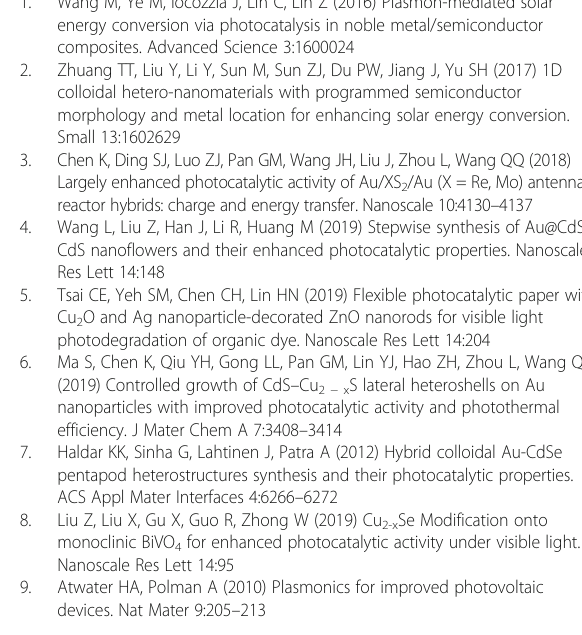
Additional file 1: Figure S1 . The HRTEM images of different types of Au/CdSe hybrid nanoparticles such as (a) Janus nanospheres, (b) heterodimers, (c) symmetric double-headed nanoparticles.